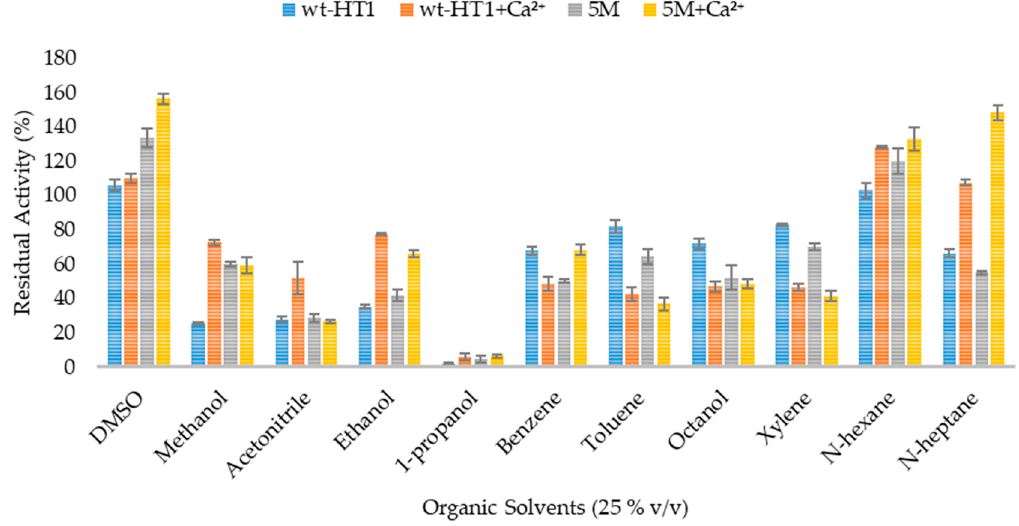
Figure 6. Effect of organic solvent on lipases activities with and without the presence of 1 mM Calcium